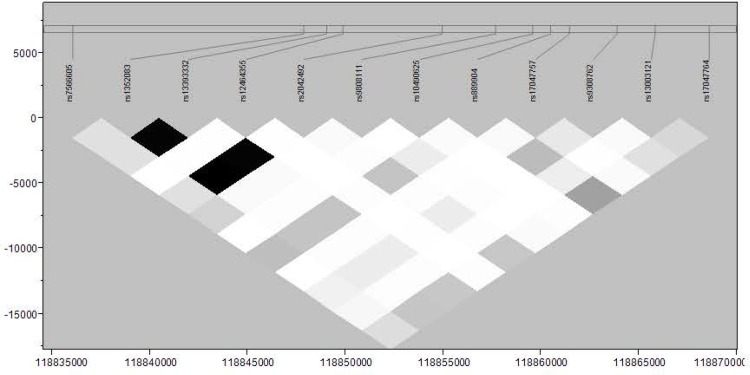
Linkage disequilibrium as measured by r2 across INSIG2 in African-Americans.